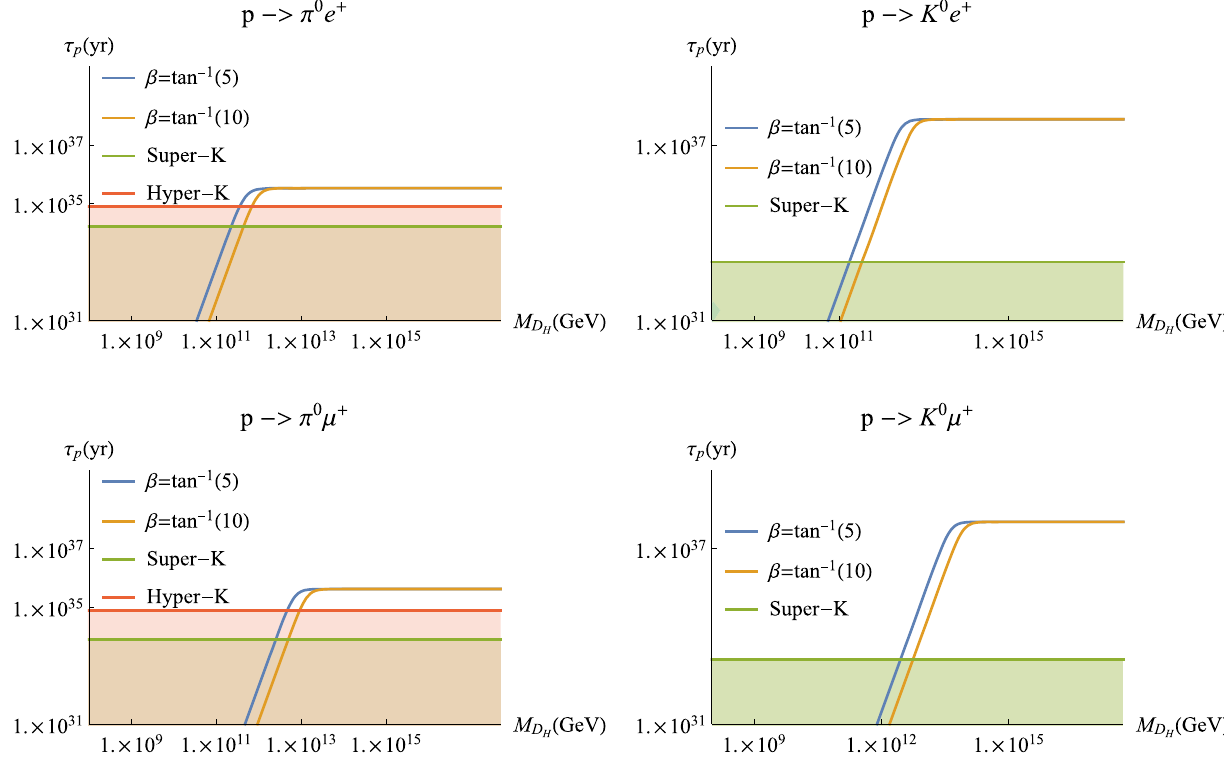
Fig. 1 The lifetime of the proton along the two decay channels ( p → π 0 ( e + ,μ + ) , p → K 0 ( e + μ + )) for different values of tan (β) . It is deduced that the triplets mass is bounded at m of the Higgs